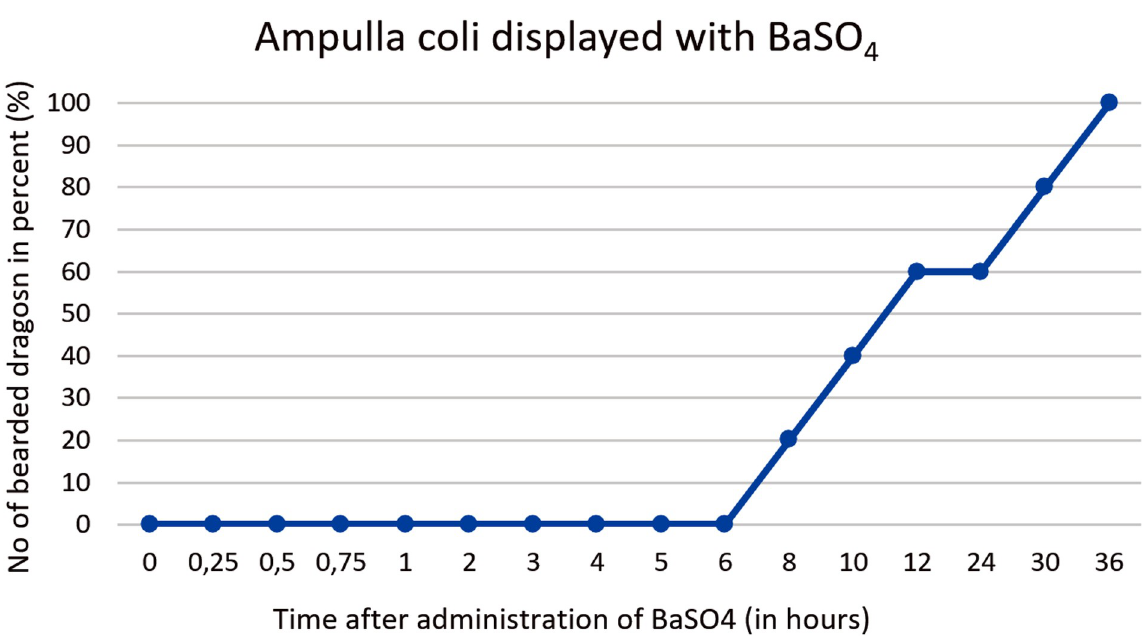
Fig 15. BaSO 4 contrast visibility in the ampulla coli over time. Percentage of animals and frequency at measuring time point; y = number of animals in percent (%) in which contrast media could be found in the ampulla coli; x = time point during BaSO 4 contrast passage (hours).